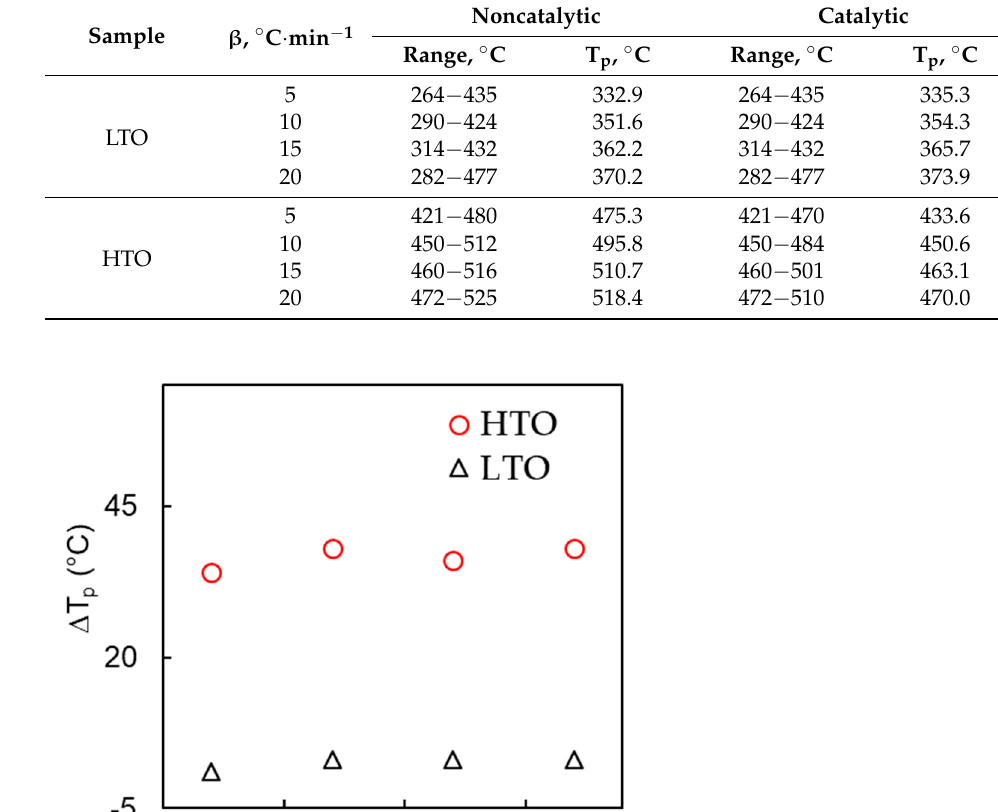
Table 1. Reaction intervals and peak temperatures for noncatalytic and catalytic oil oxidation.